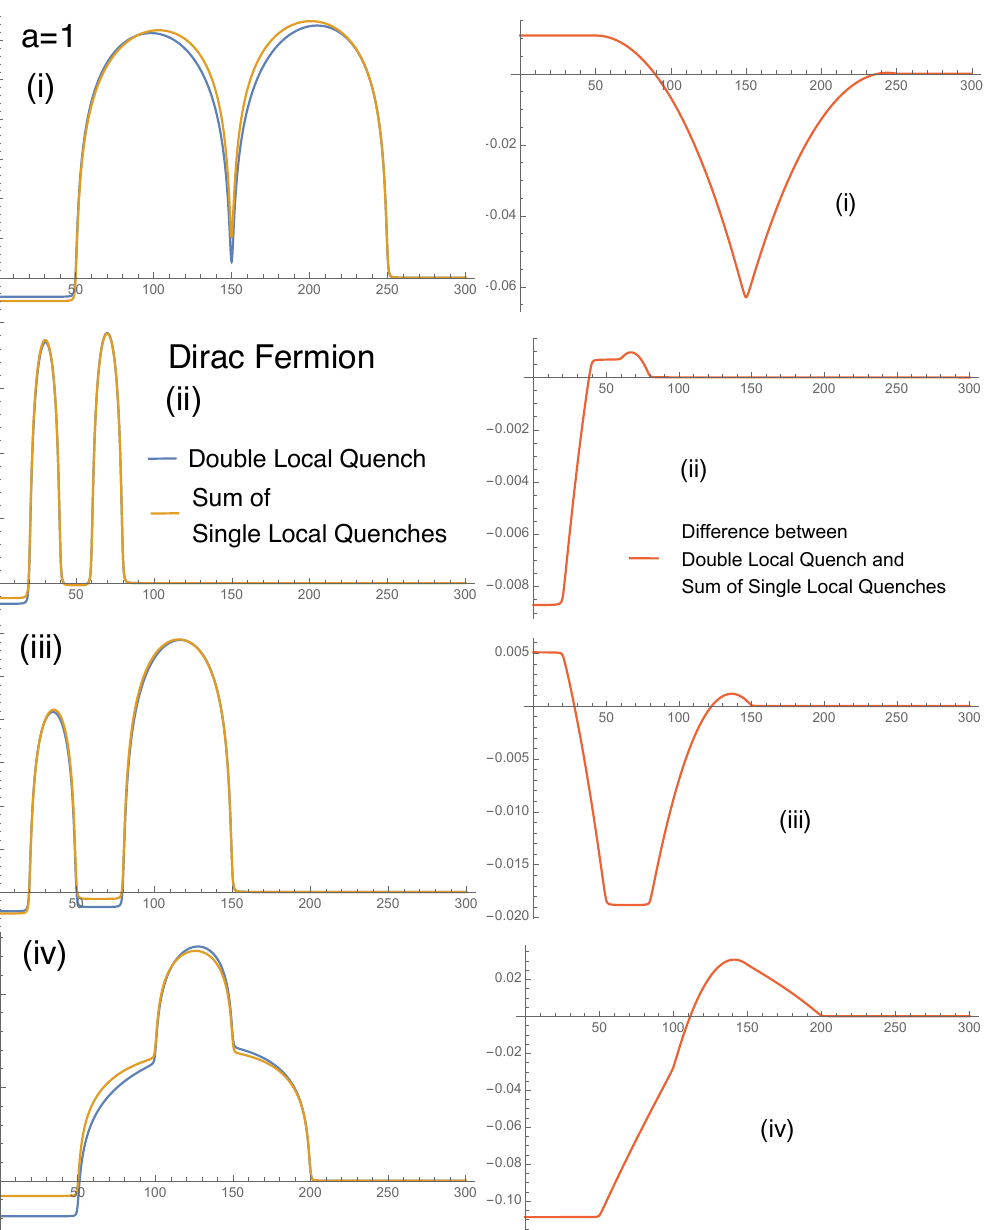
Figure 28 . The plots of (cid:1) S double of the Dirac Fermion CFT for the double joining local quench A (left) and the di(cid:11)erence (cid:1) S D (cid:1) S S ( x = b ) (cid:1) S S ( x = (cid:0) b ) between the double and single quench (right) A (cid:0) (cid:0) as a function of t . We set b = 50 and a = 1. From the top to bottom we presented results for the four di(cid:11)erent setups (i), (ii), (iii) and (iv). In the left plots, the blue and orange graph describes (cid:1) S D and (cid:1) S S ( x = b ) (cid:1) S S ( x = (cid:0) b ) , respectively. In the right plots, the red graphs describe the A (cid:0) di(cid:11)erence (cid:1) S D (cid:1) S S ( x = b ) A (cid:0)